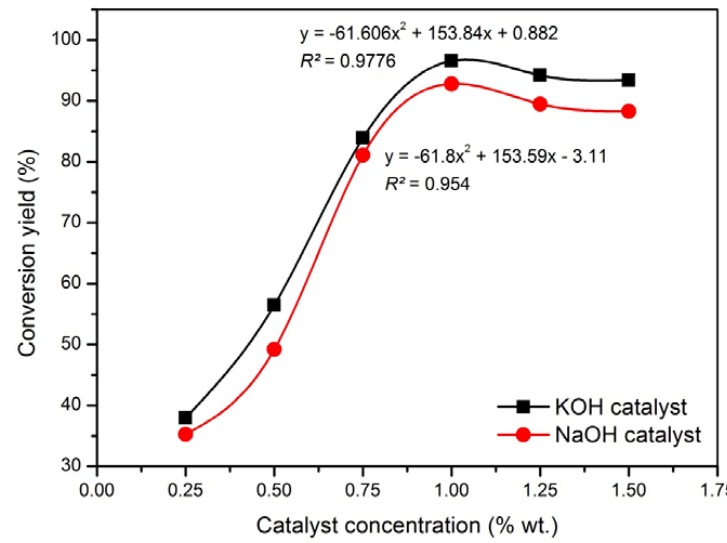
Figure 5. Effect of catalyst concentration on mandarin biodiesel conversion yield at 60 °C reaction temperature, 6:1 methanol–oil ratio and 60 min reaction time.